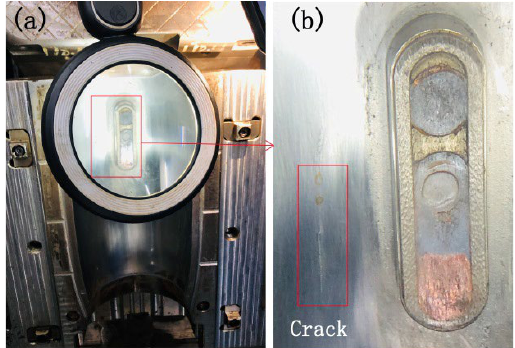
Figure 1. A long crack in a mold cavity: ( a ) 718H mold cavity and ( b ) scale of the crack. Paris et al. [11] first proposed that the relationship between fatigue crack growth rates per cycle ( d α / dN ) and the stress intensity range ( ∆ K ) could be described